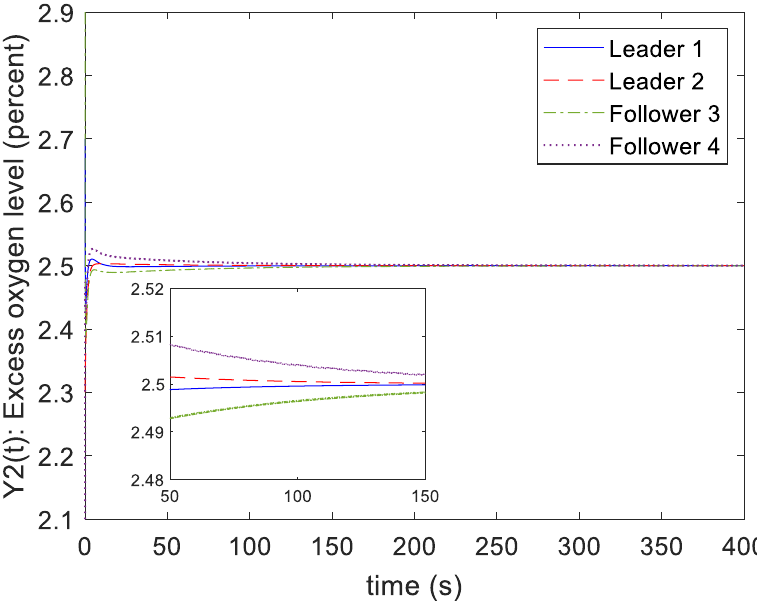
  Y t with type-1 robust fuzzy control. Figure 19. Responses of output Y 2 ( t ) with type-1 robust fuzzy control. 2